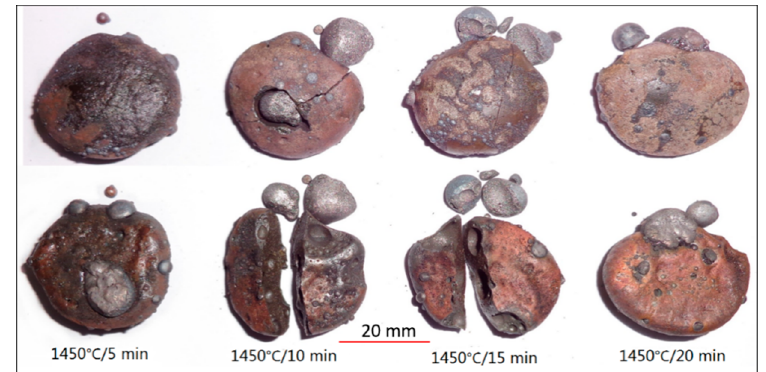
Figure 13. The photos of the iron nuggets and alumina obtained at the optimal condition.